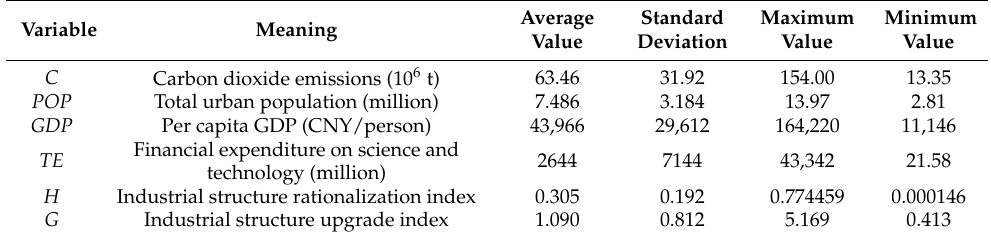
Table 2. Variable description and descriptive statistics.